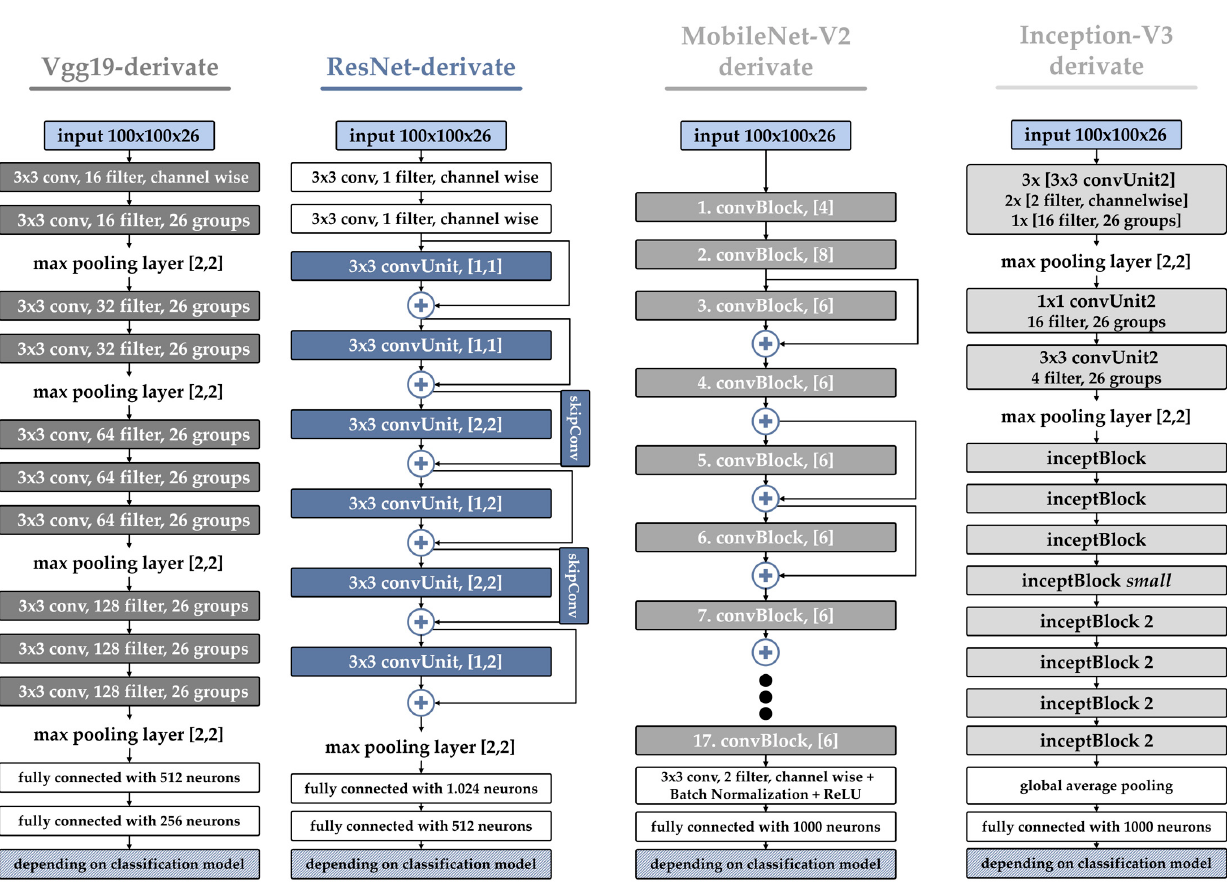
Figure 9. Comparison of different network architectures adapted for channel-wise input of trans- formed FE simulation matrices.